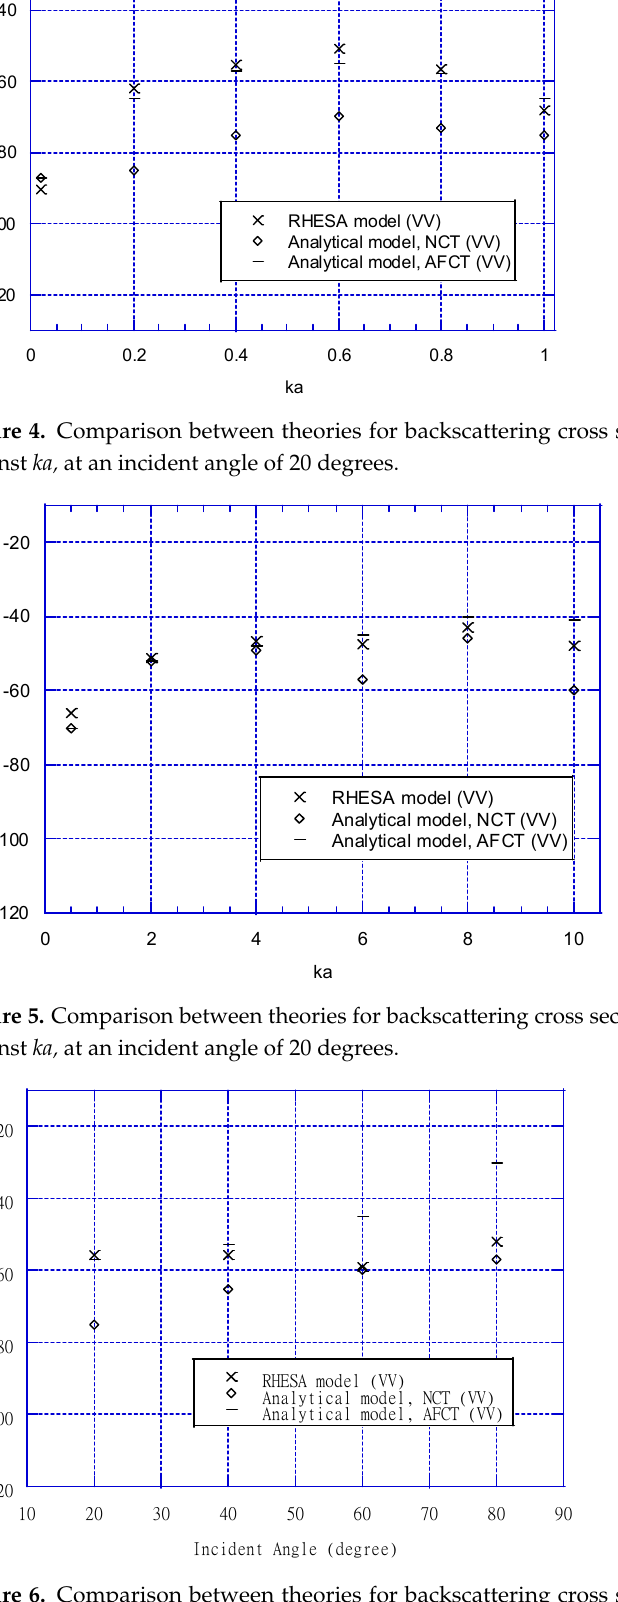
Figure 6. Comparison between theories for backscattering cross section of a cylindrical scatterer against incident angle, at a frequency of 9.6 GHz.